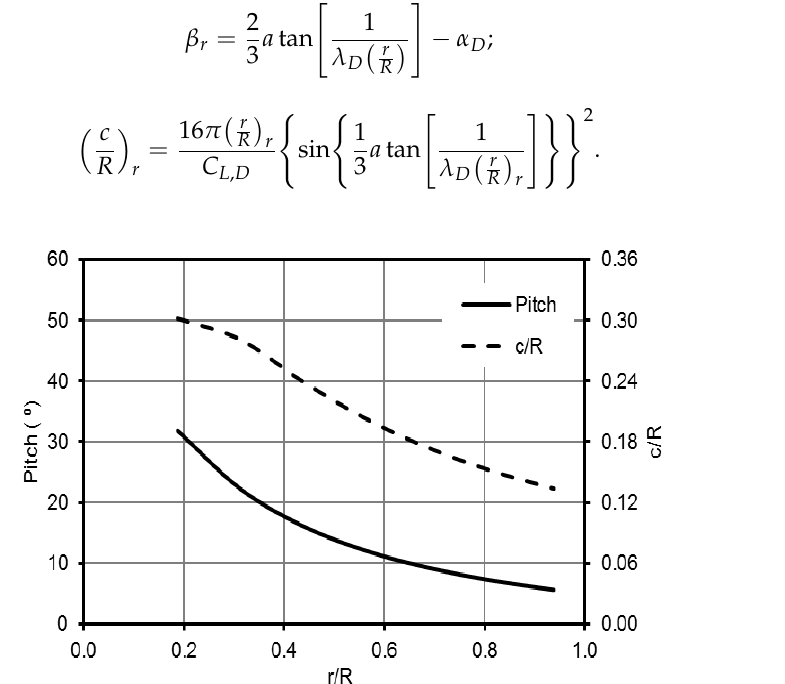
Figure 1. Designed pitch and normalized chord lengths spanwise.